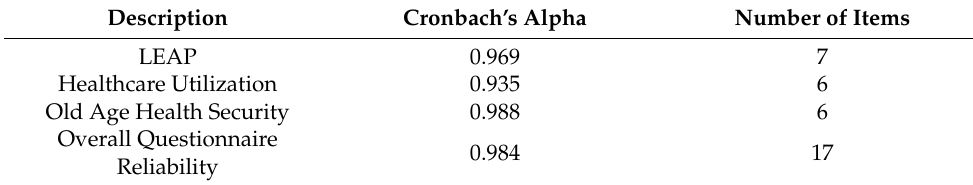
Table 2. Reliability Statistics of variables.